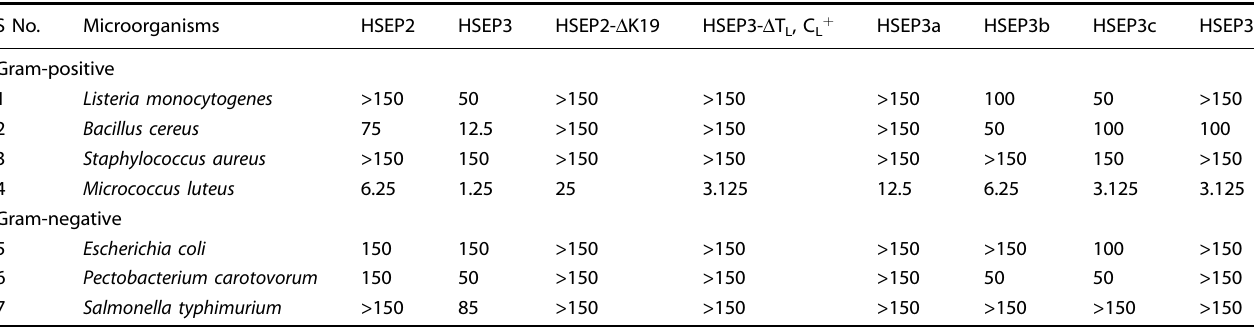
Table 2. MICs of the peptides against tested bacteria.